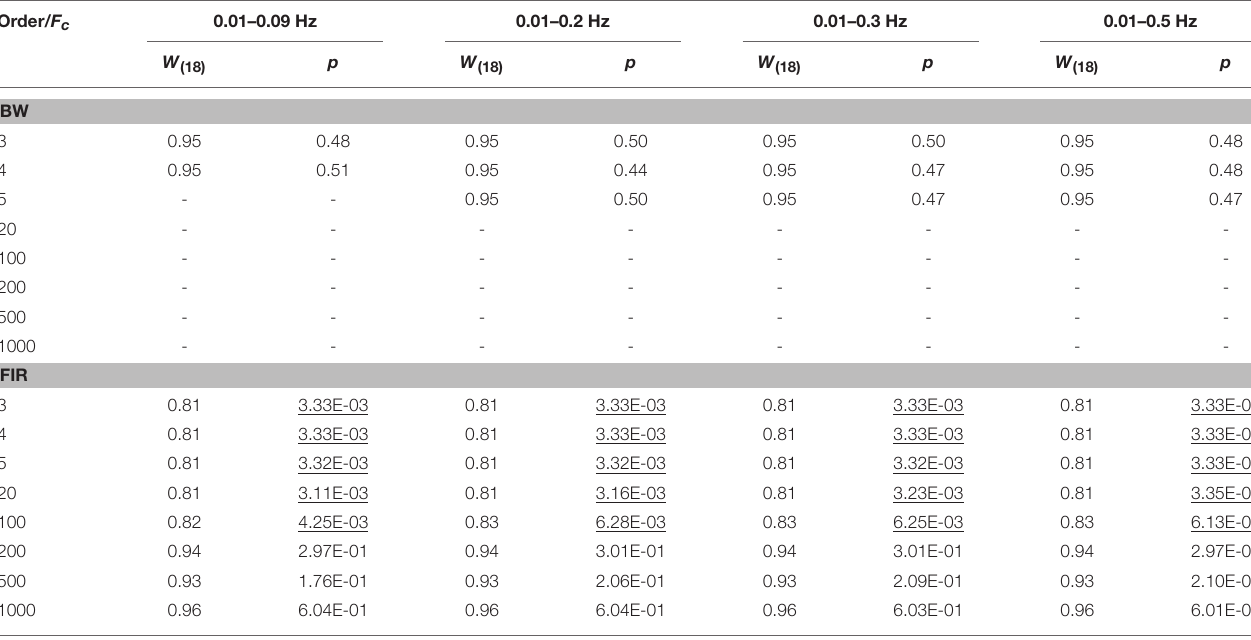
TABLE 3 | Shapiro-Wilk test results computed on 1 HbR C BP filtered data, with Amplitude 1. Order/ F